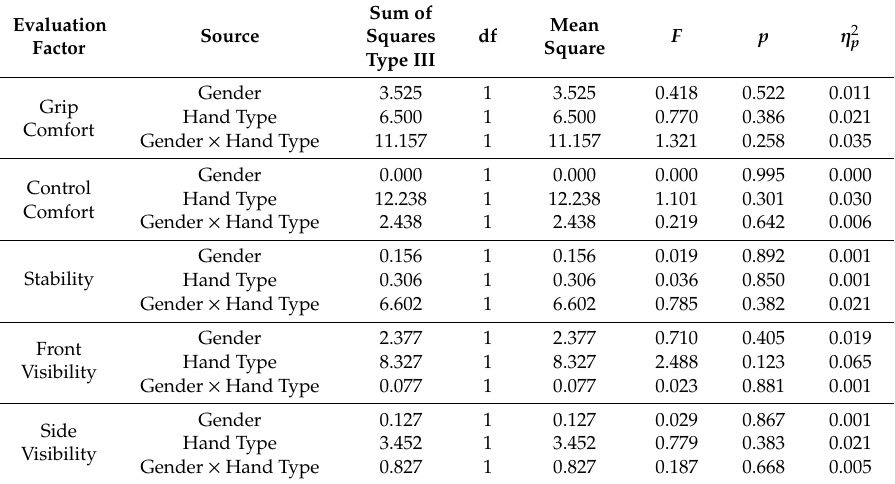
Table 4. Test result of between subject e ff ects (based on the results of two mixed ANOVAs). Evaluation Factor